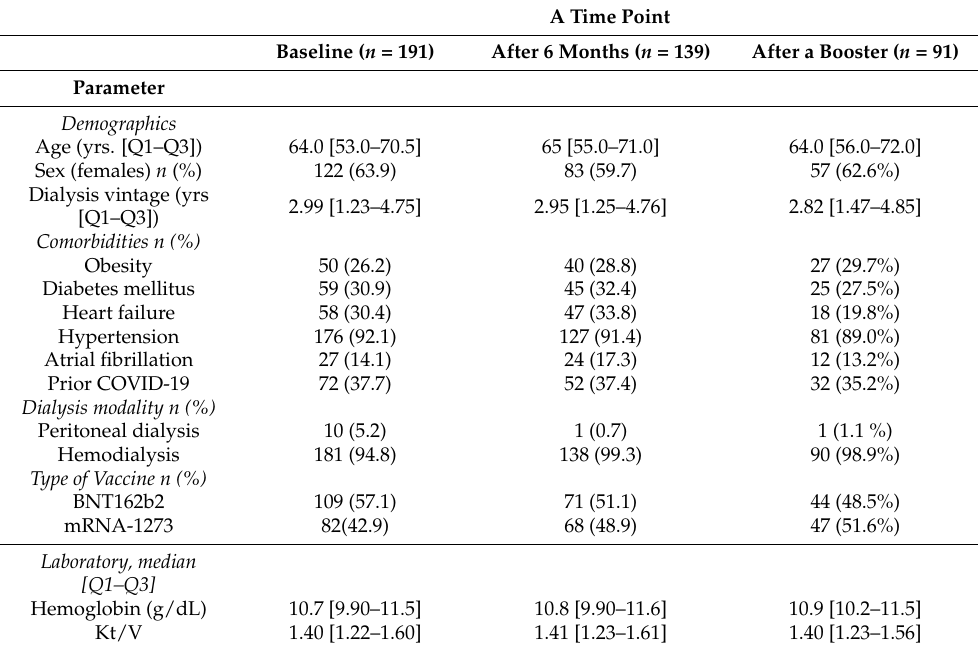
Table 1. Characteristics of studied population at different time points of study duration